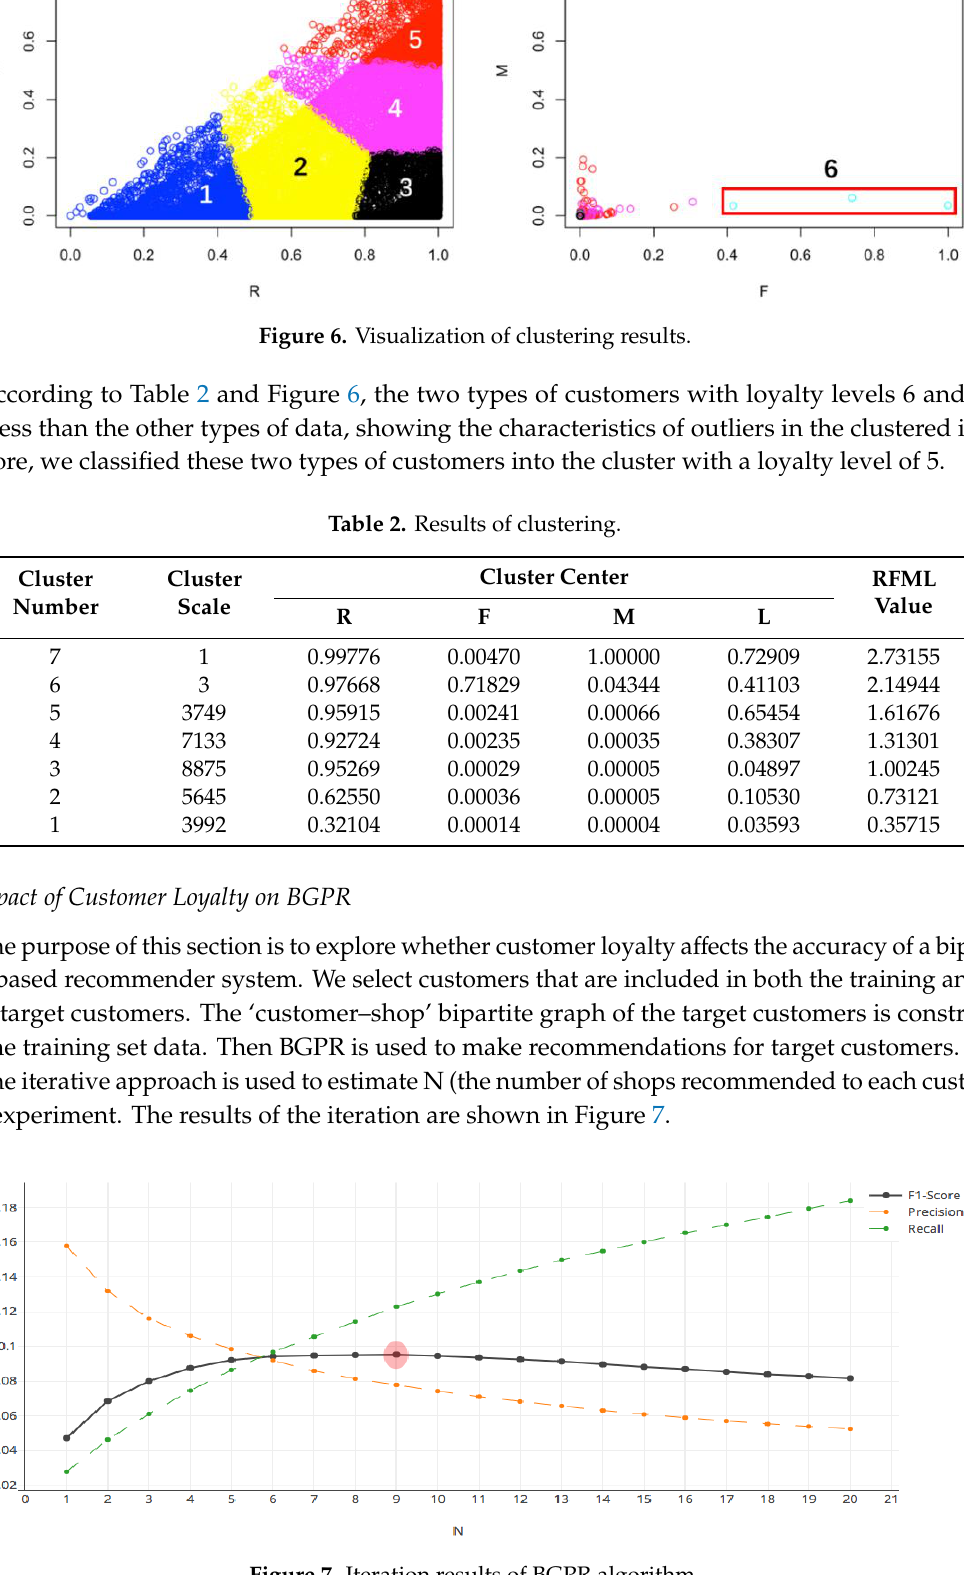
Figure 7. Iteration results of BGPR algorithm.